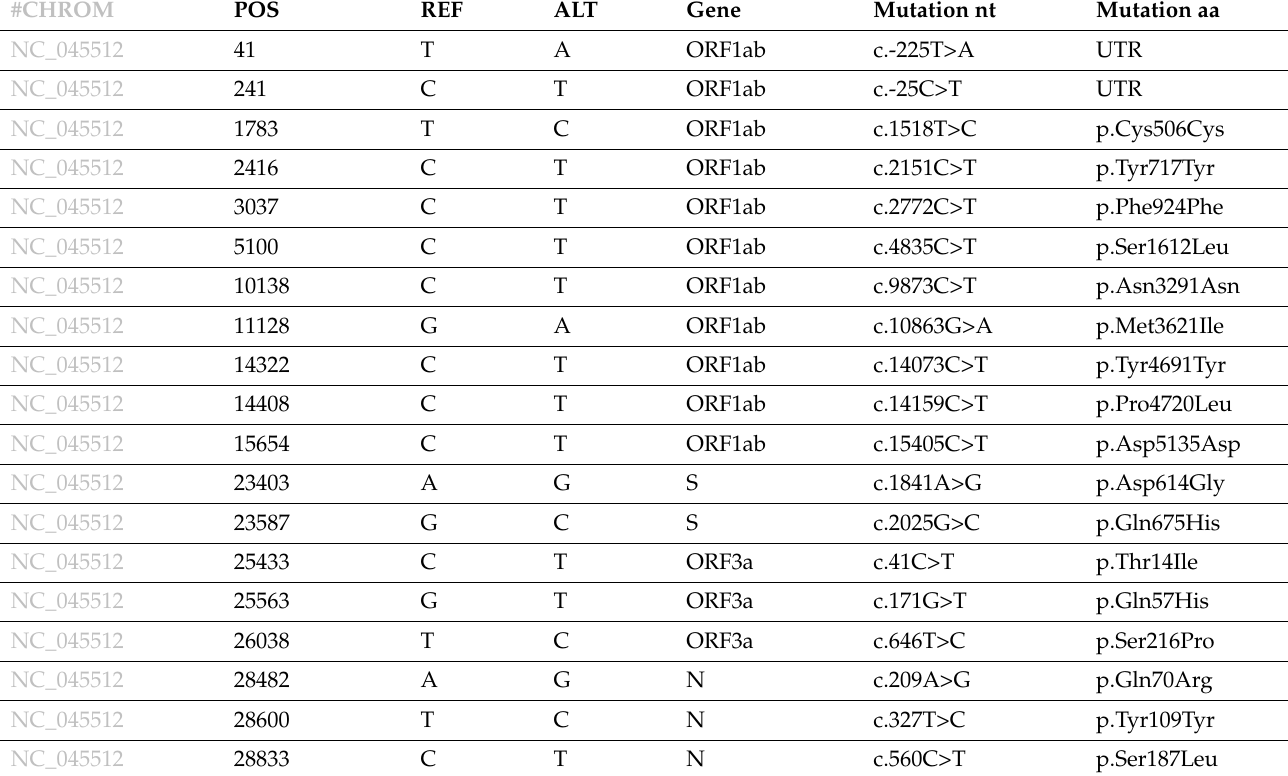
Figure 5. Neighbor-joining phylogenetic tree.